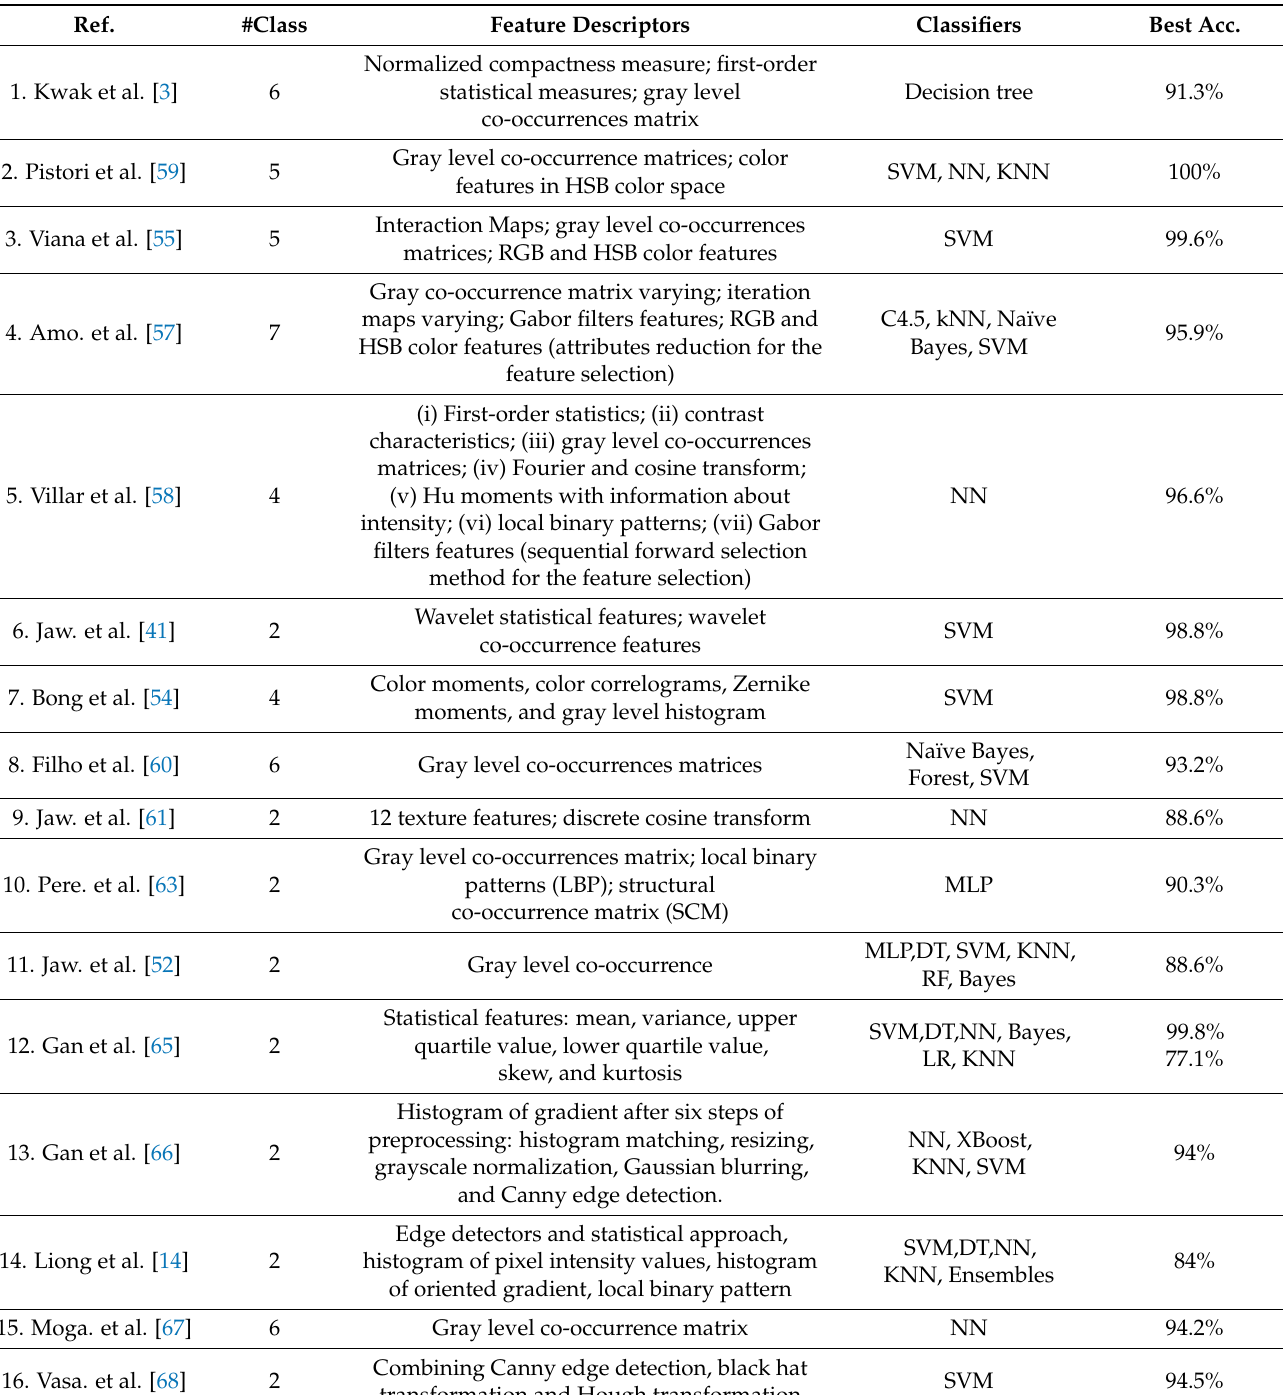
Table 3. Traditional machine-learning-based leather surface defect identifications.